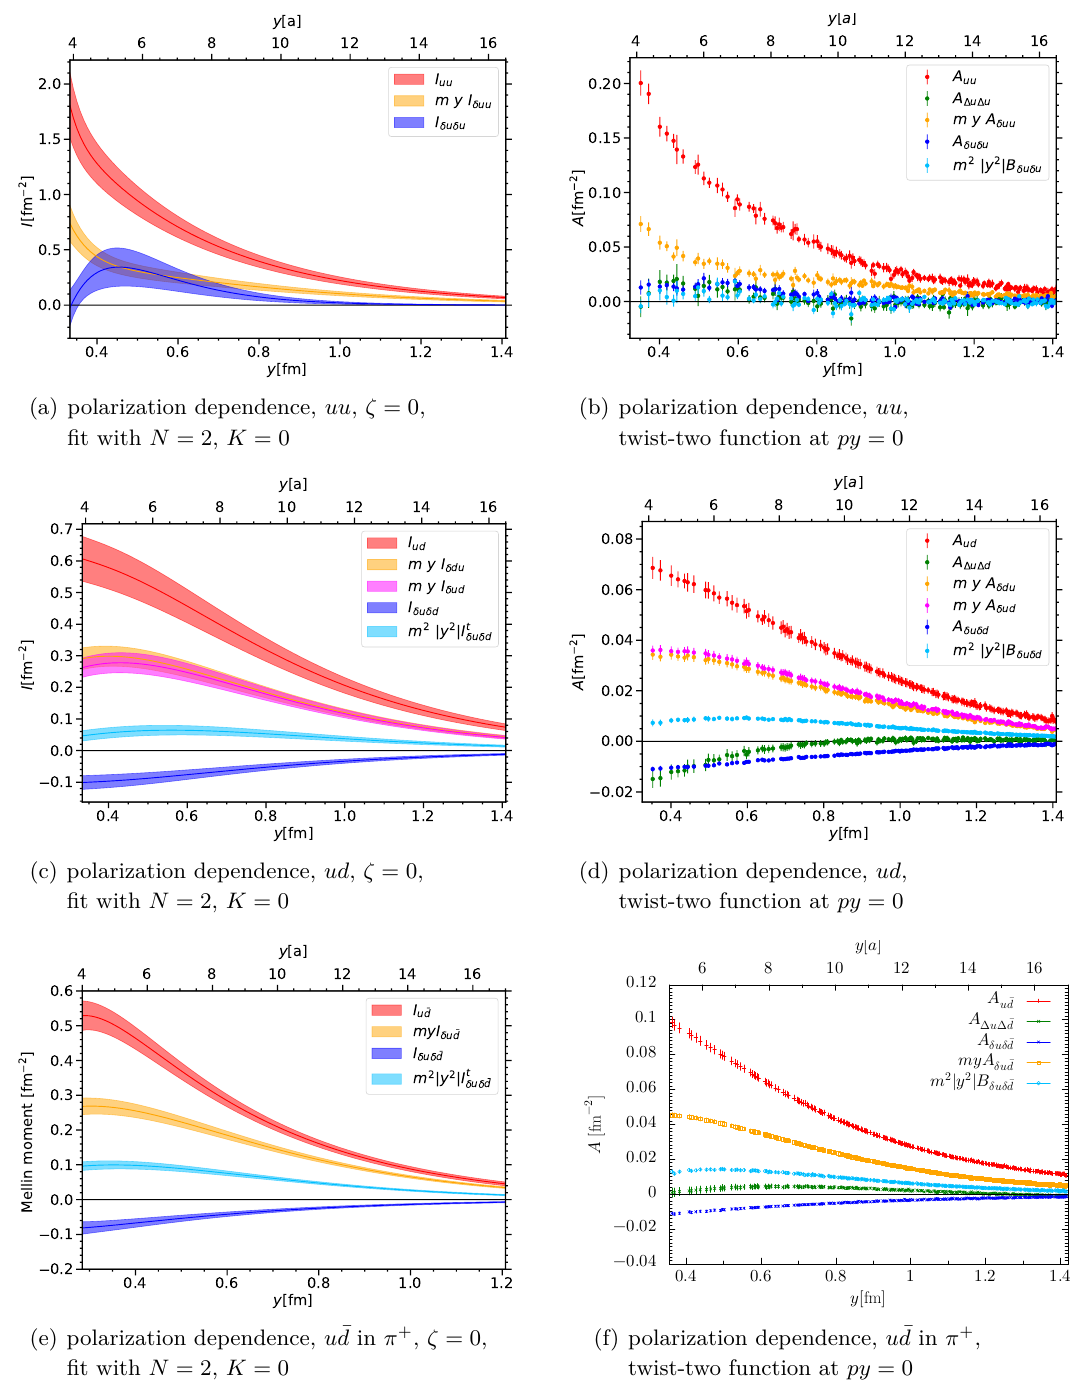
Figure 22 . Comparison between different quark polarizations for the flavor combinations uu (a,b) and ud (c,d). The left panels show the results for the Mellin moments obtained from the fit with ( N, K ) = (2 , 0) . In the right panels we again show the data for the corresponding twist-two functions, which was already plotted in figure 13. Panels (e) and (f) show the results for u ¯ d in the π + , which were calculated in